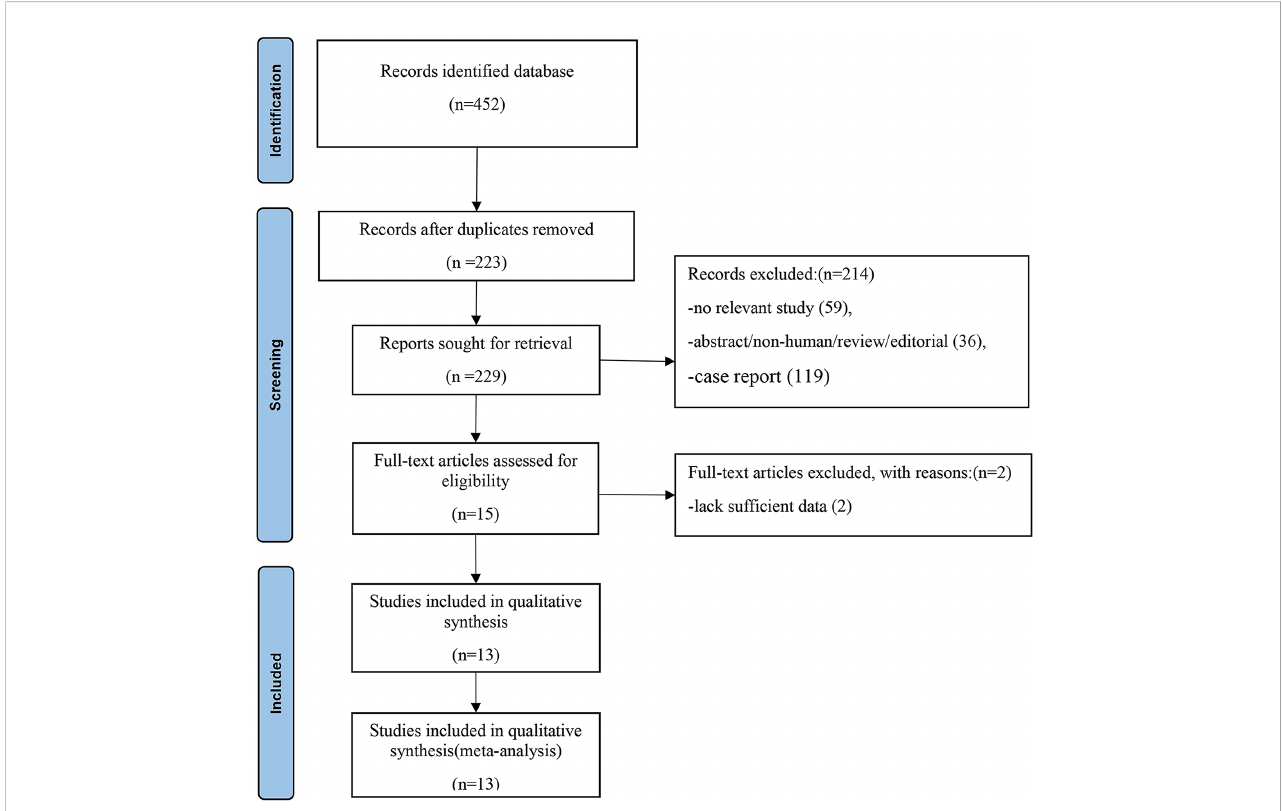
FIGURE 1 Flowchart of the search for eligible studies on 68 Ga-PAFI and 18 F-FDG PET/CT in patients of abdominal and pelvic malignancies. Thirteen articles were fi nally selected for this